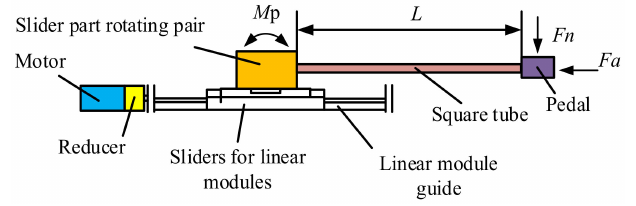
Figure 6. Static analysis of linear